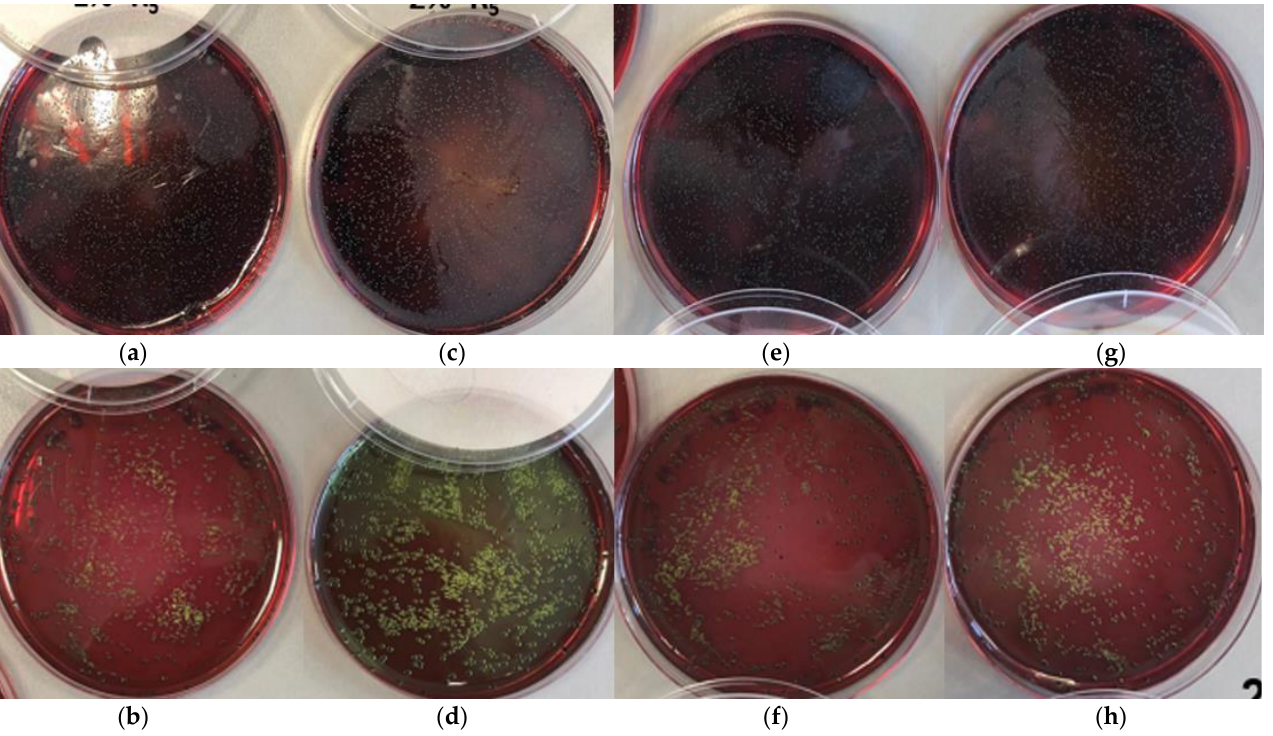
Figure 7. Antibacterial activity of ( a ) PLA/R1 compound with Listeria monocytogenes ( b ) PLA/R1 compound with E. coli ( c ) PLA/R2 compound with Listeria monocytogenes ( d ) PLA/R2 compound with E. coli ( e ) PLA/S1 compound with Listeria monocytogenes ( f ) PLA/S1 compound with E. coli ( g ) PLA/S2 compound with Listeria monocytogenes ( h ) PLA/S2 compound with E. coli. At the same time, in the microtiter plate assays, the results obtained (Figure 8a) are consistent with the previous ones; in pellet form, the compounds PLA/R1, PLA/R2, PLA/S1 and PLA/S2 have turbidity (Figure 8b) resulting in a very mild inhibition of bacteria Listeria monocytogenes and E. coli.